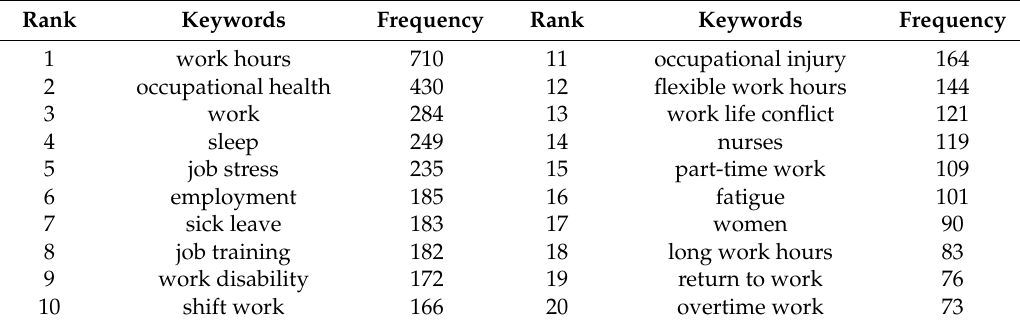
Table 2. Top 20 high-frequency keywords related to work